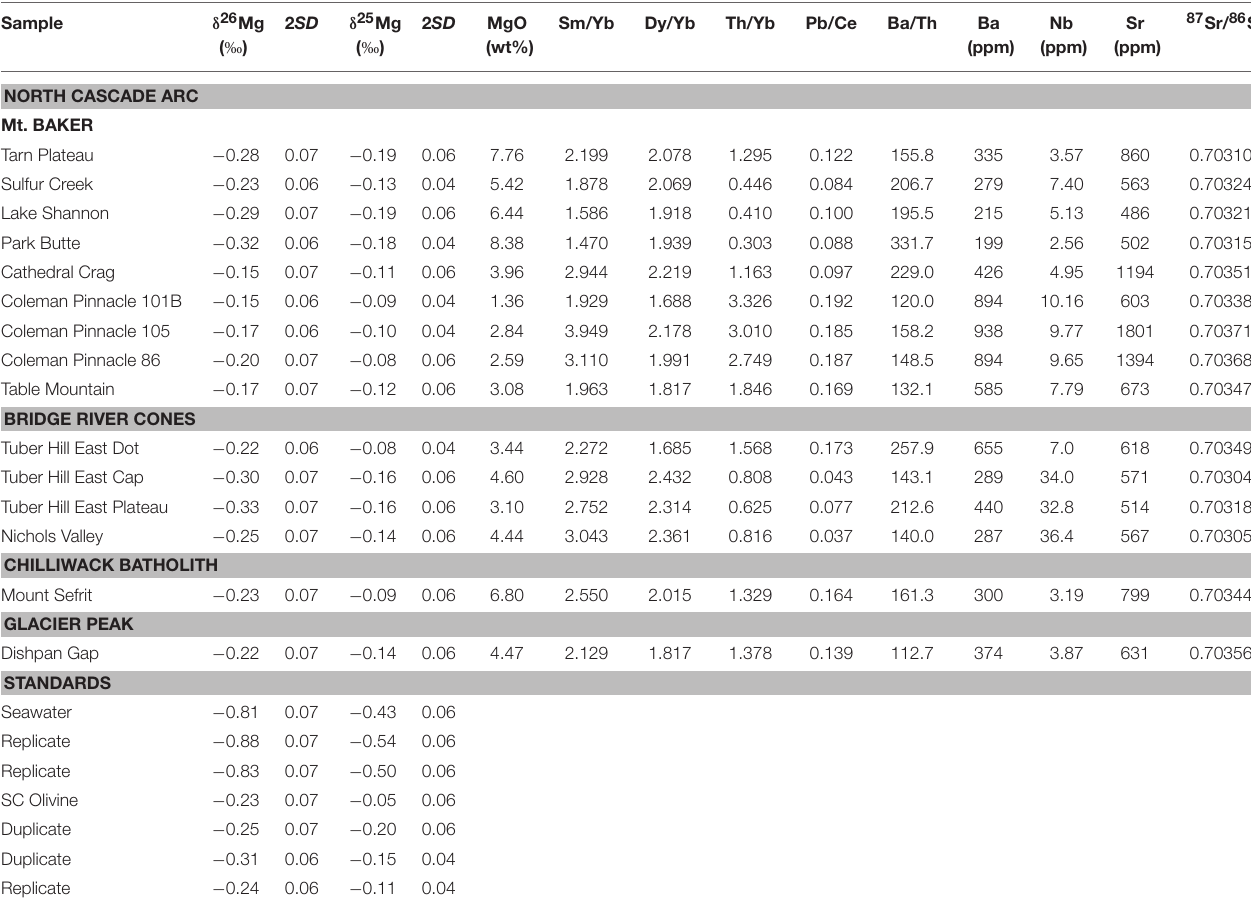
TABLE 1 | Magnesium isotope and trace element compositions of samples and standards a